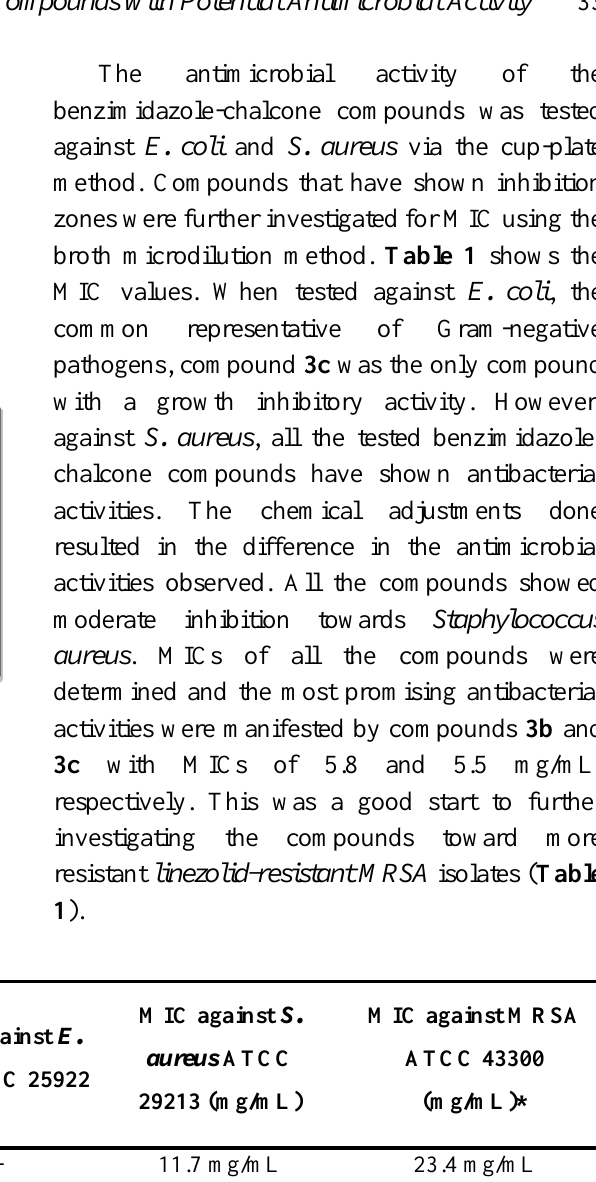
Cpd.# Substituent